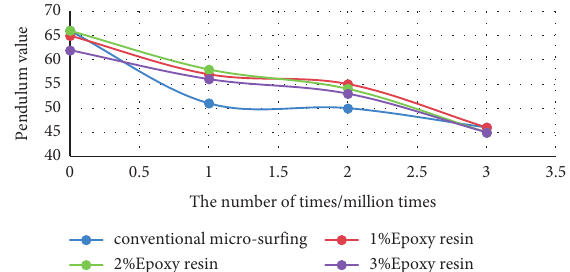
Figure 5: Curve of British pendulum number of epoxy high- performance